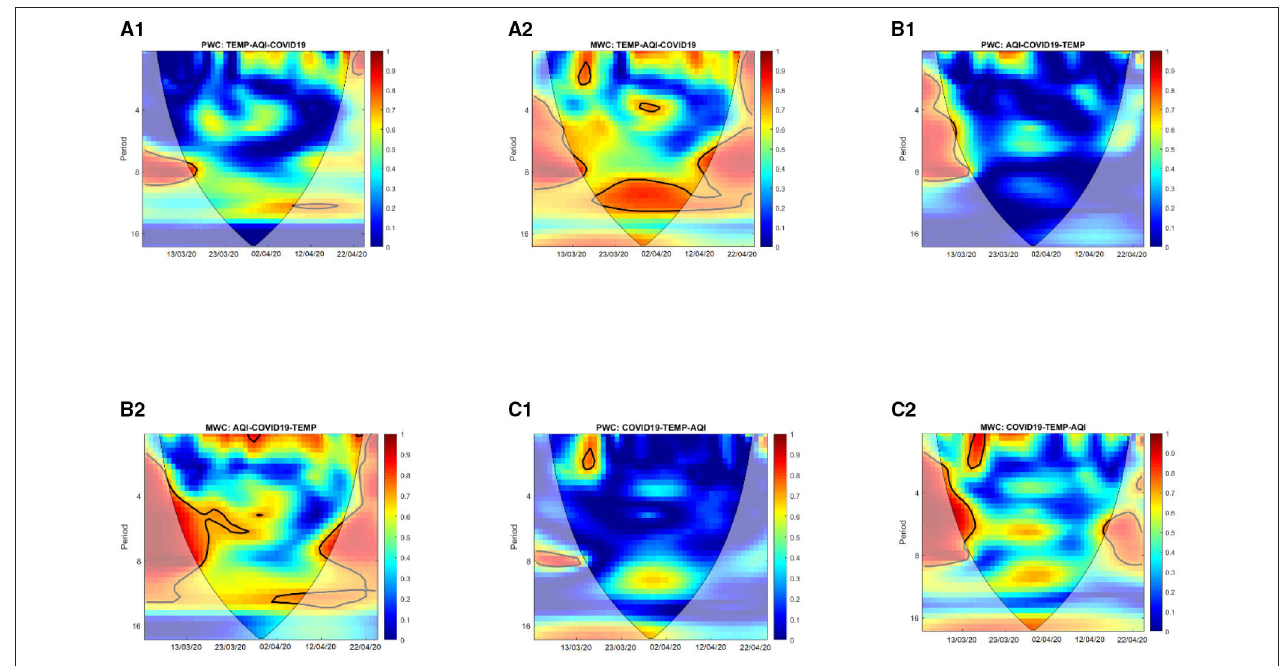
FIGURE 5 | Partial and multiple wavelet coherence of TEMP, AQI and